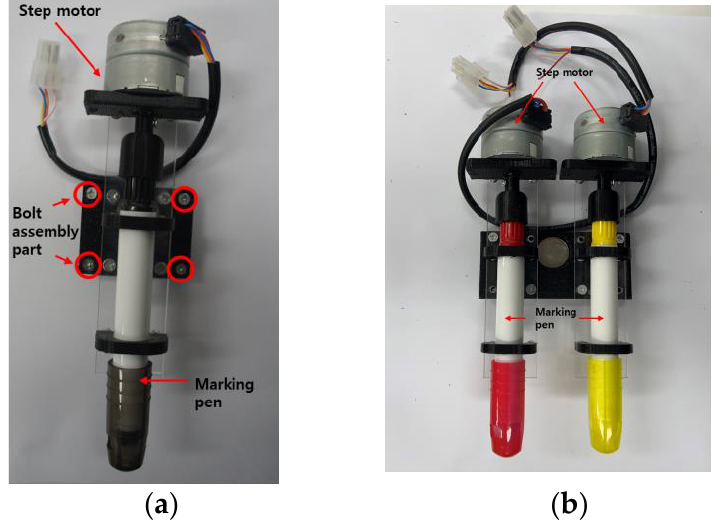
Figure 5. Marking toolkit modules: ( a ) single-type; ( b ) double-type.